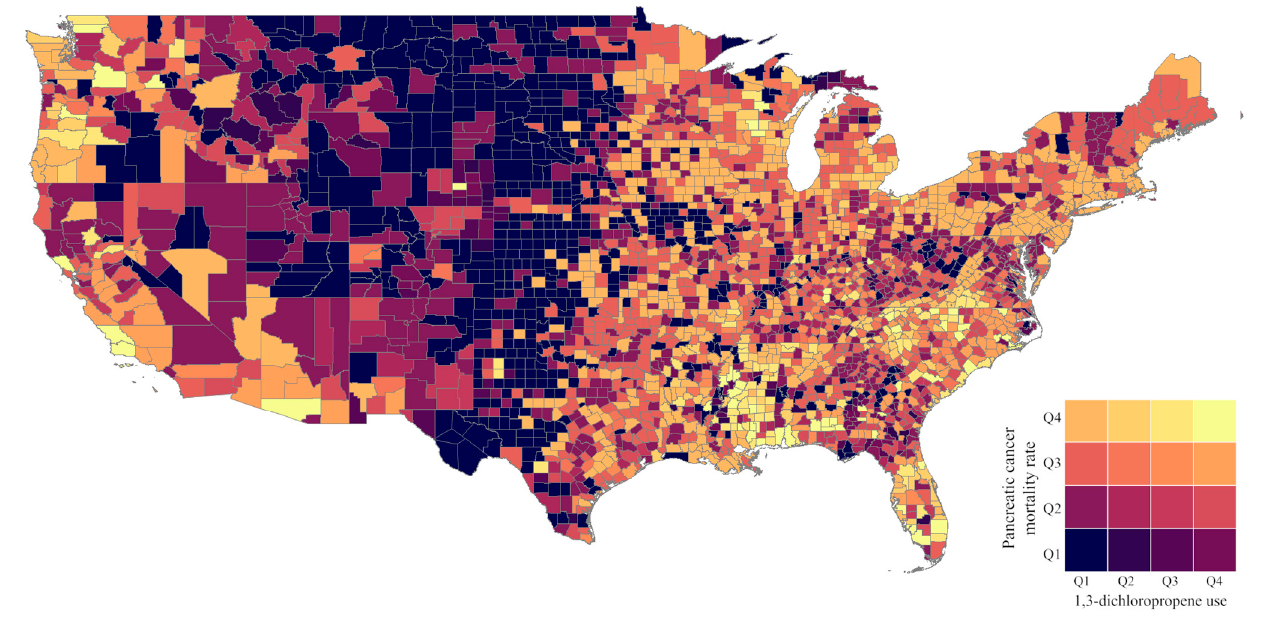
Figure 2. Choropleth map of combined 1,3-dichloropropene use and pancreatic cancer mortality rate by county. Table 3. Rate ratios * (RRs) and associated 95% confidence intervals (CIs) for the association between 1,3 dichloropropene (1,3-D) use and pancreatic cancer-related mortality. 1,3-D Use